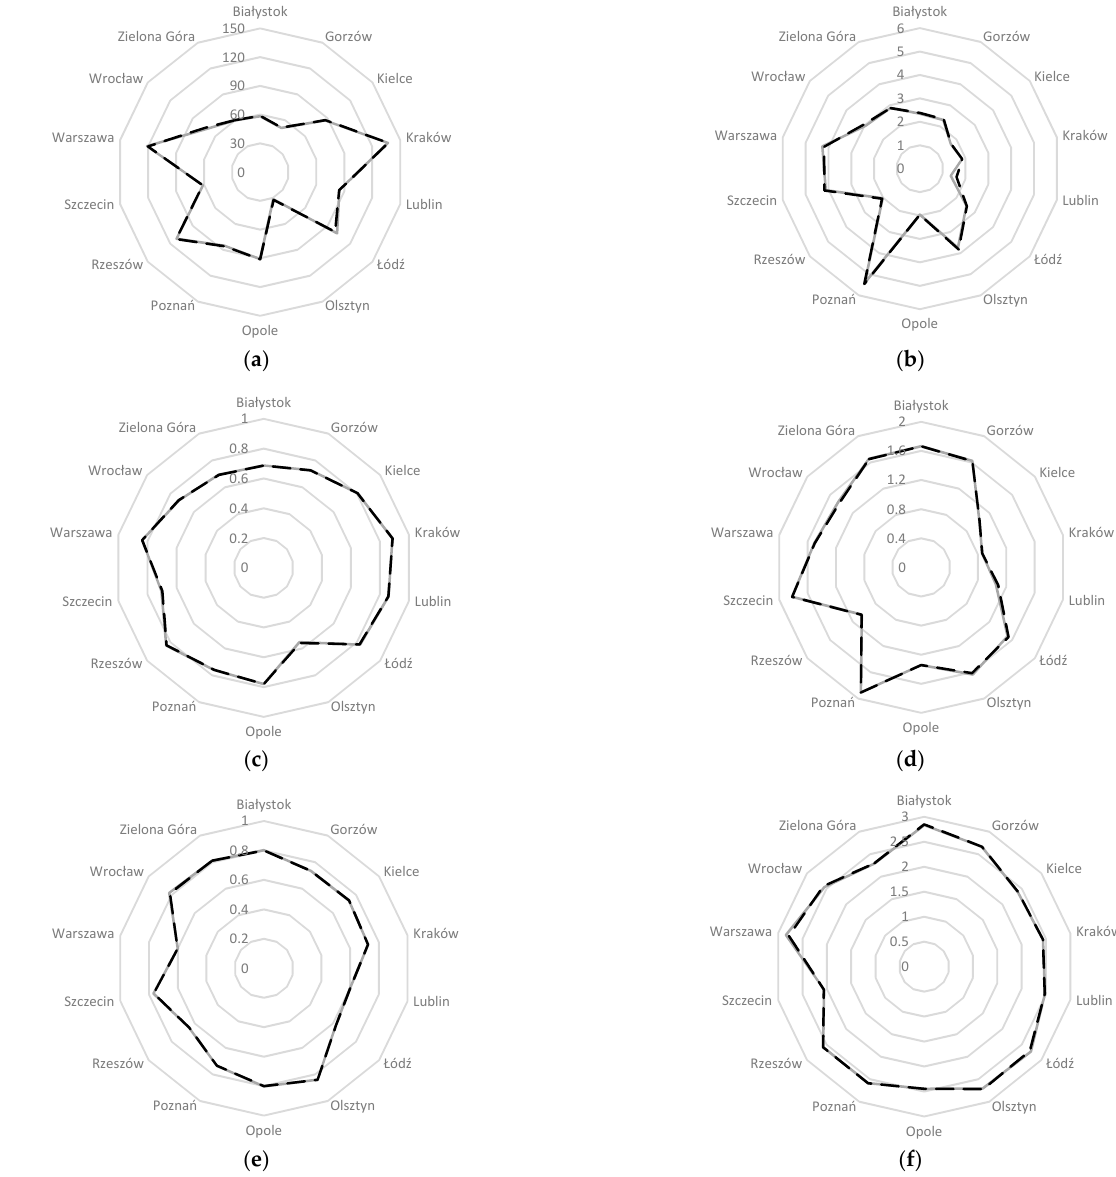
Figure 2. Values of morphological indicators for 2015 and 2017: ( a ) Density – D iu ; ( b ) Urbanization pressure - UP(j i);